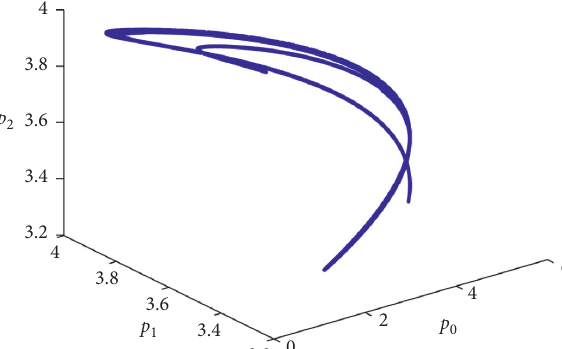
Figure 10: Strange attractor when ρ � 0 . 27.